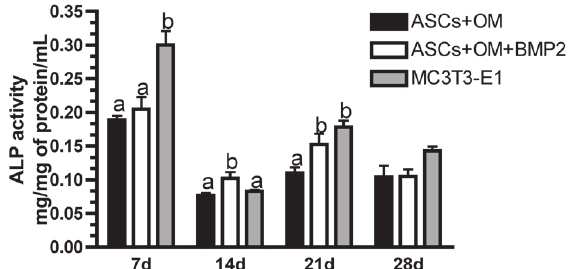
Figure 1- Alkaline phosphatase (ALP) activity. Enzymatic activity at days 7, 14, 21, and 28. Different letters refer to statistical significant differences (ANOVA/SNK, ρ<0.05)